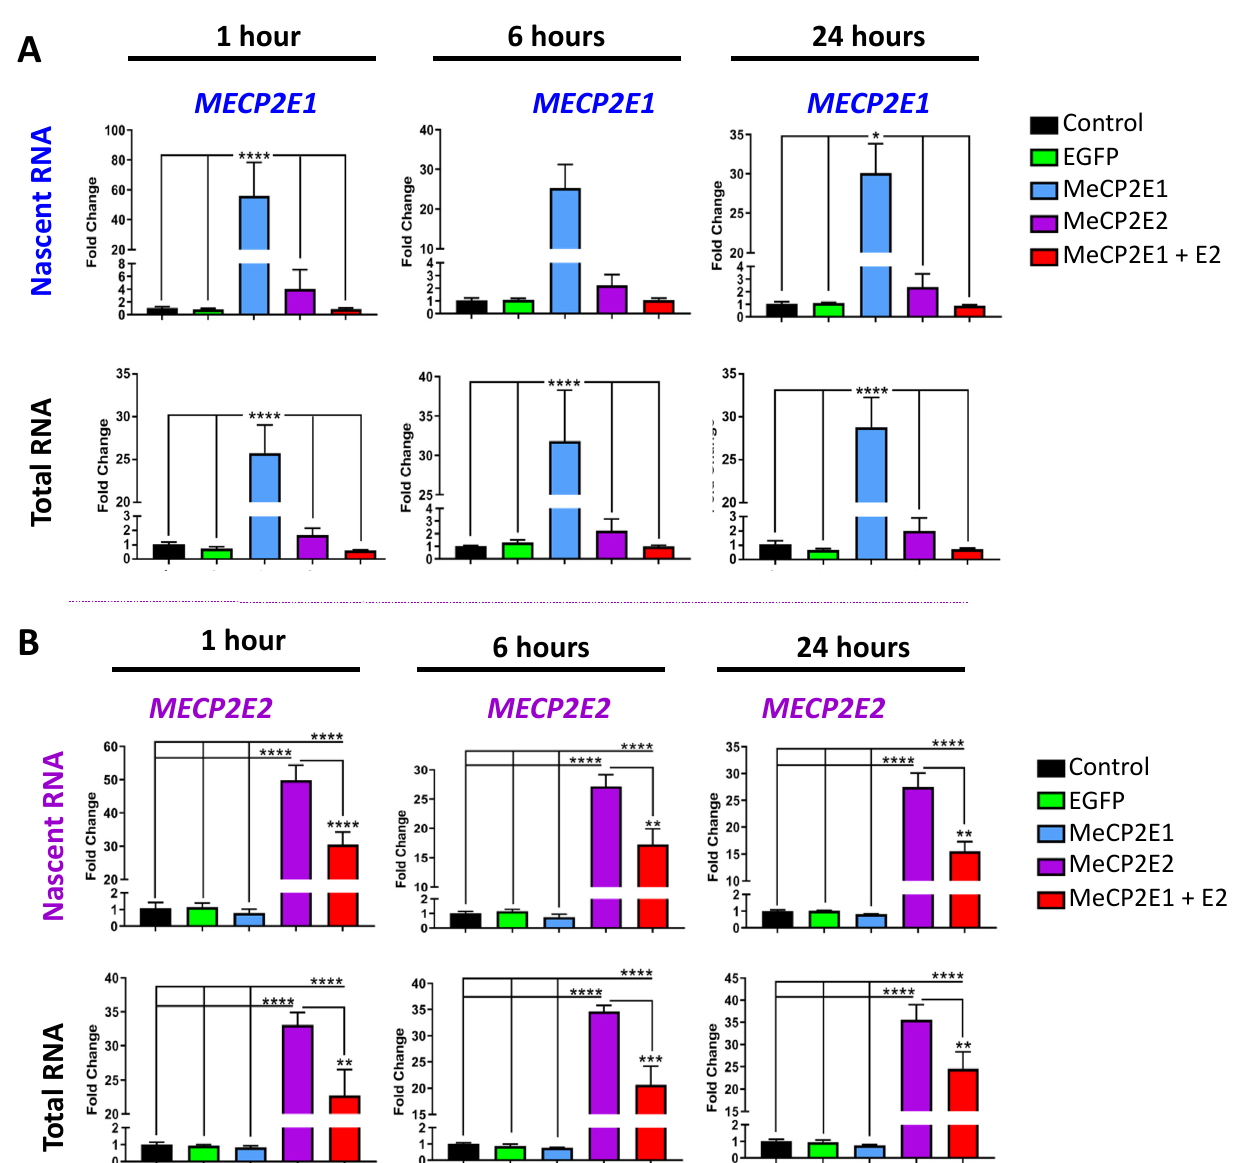
Figure 4. Expression of nascent and steady-state MECP2E1 and MECP2E2 transcripts in Daoy cells transduced with lentiviral vectors expressing MeCP2 isoforms. Nascent RNA was prepared from cells labelled with EU for 1 h, 6 h, and 24 h. Total RNA was prepared from unlabeled cells collected at the same time points. Gene expression was analyzed by RT-PCR for ( A ) MECP2E1 transcripts and ( B ) MECP2E2 transcripts. C T values were normalized to the housekeeping gene GAPDH, and fold change was determined relative to average non-transduced control cells with n = 3, and data are reported as mean ± SEM. Fold change values were analyzed by two-way ANOVA followed by Tukey’s multiple comparisons test. The levels of significance are *: p < 0.05, **: p < 0.01, ***: p < 0.001, and ****: p < 0.0001.